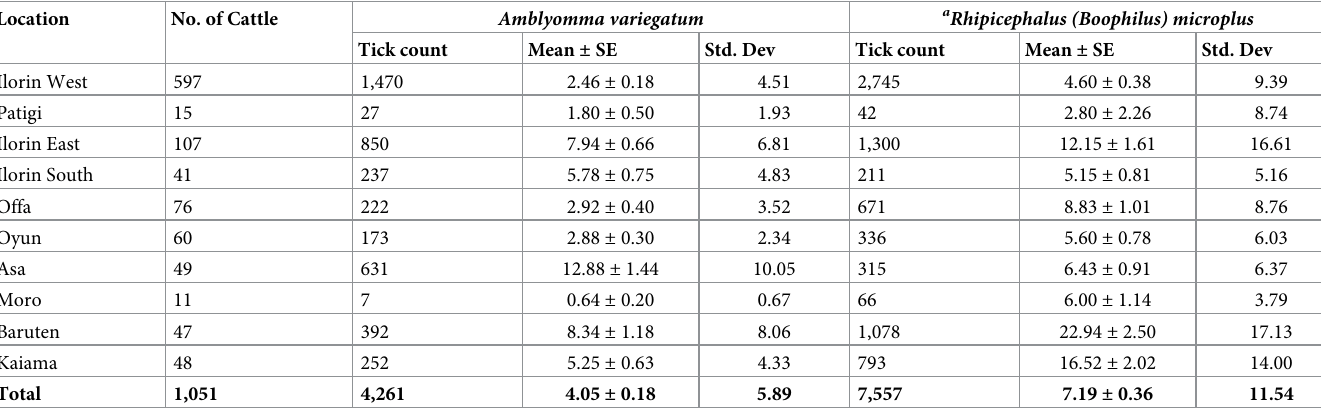
Table 3. Distribution of Amblyomma variegatum and Rhipicephalus ( Boophilus ) microplus infesting cattle in Kwara State based on location.